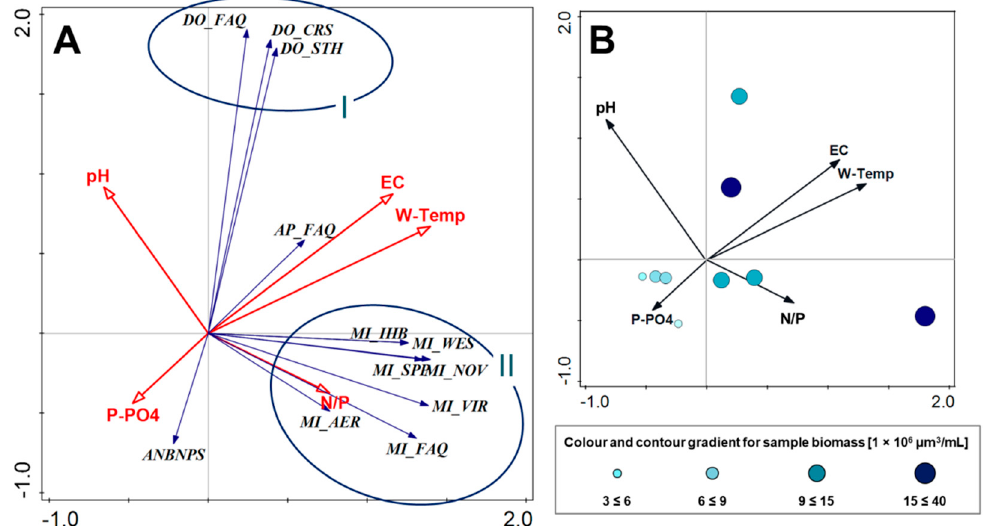
Figure 9. The PCA ordination plot displaying the relations between the biomass of cyanobacteria and hydrochemical factors; ( A ): relations between cyanobacteria taxa and studied factors; ( B ): relations between total cyanobacteria biomass in samples and studied factors.